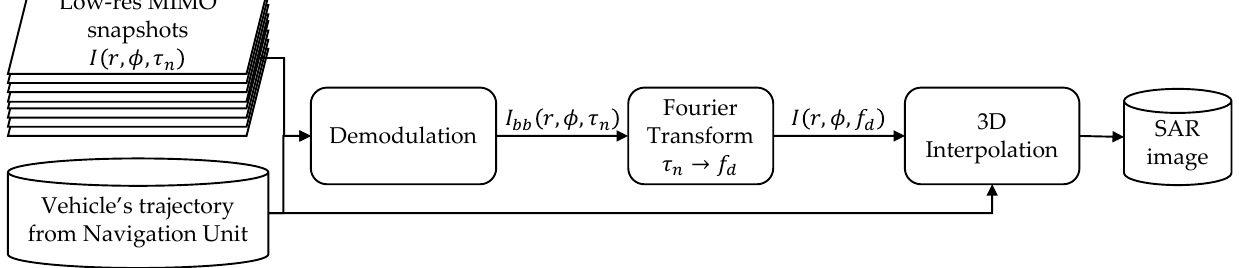
Figure 5. Block diagram of the 3D2D